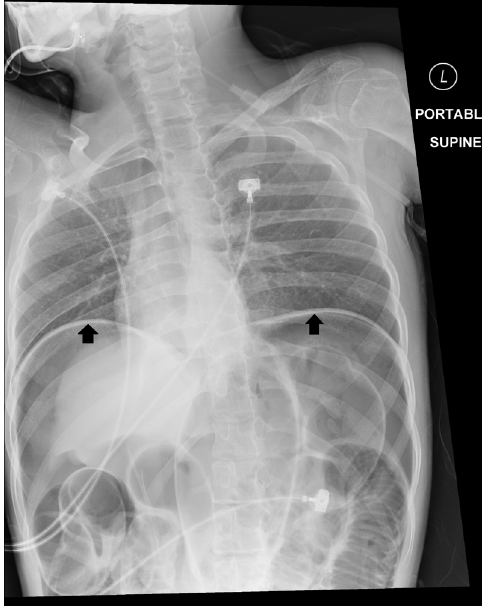
Figure 1. Initial chest x-ray demonstrating elevated diaphragm (black arrows).